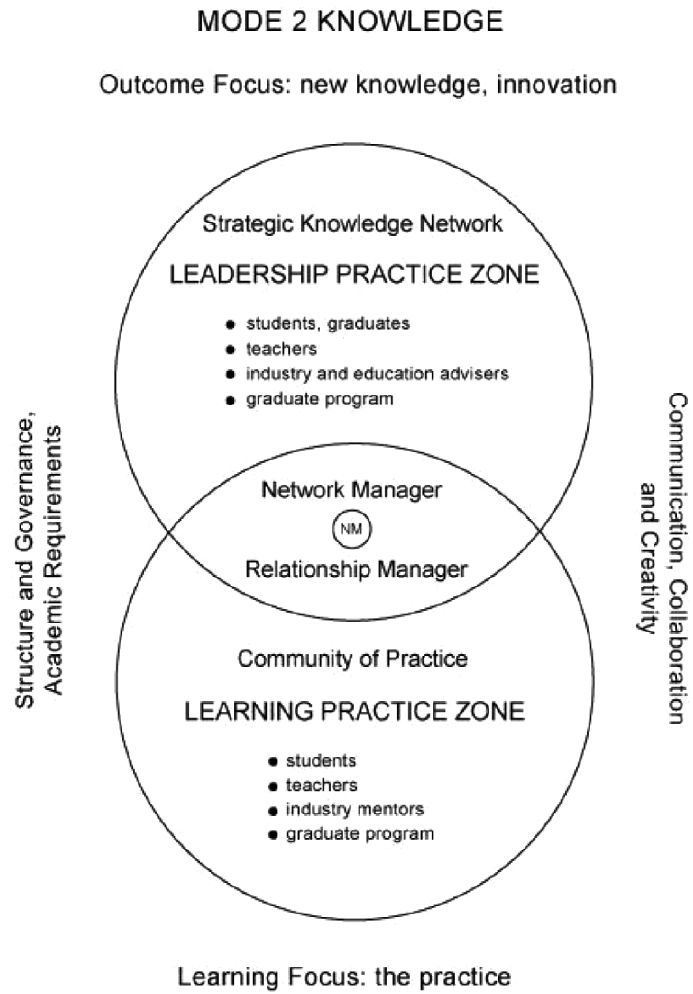
Figure 1. Two-tiered model – a strategic knowledge network supported by